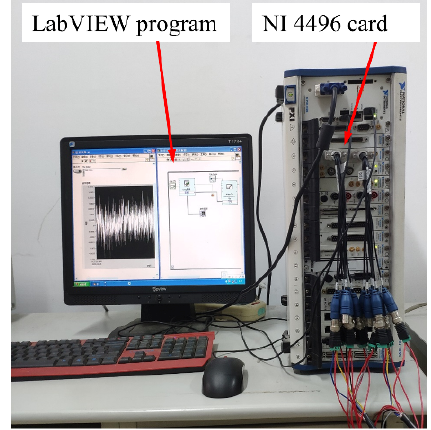
Figure 8. The data acquisition system.